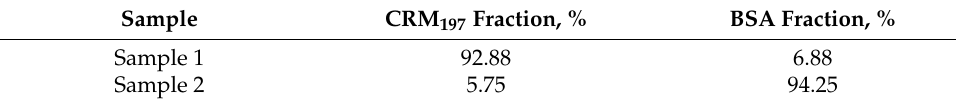
Figure 2. Electropherograms of binary mixtures of 90%CRM 197 -10%BSA ( Sample 1 ), on the left, and 10%CRM 197– 90%BSA ( Sample 2 ), on the right. Table 6. Protein fraction obtained with LabChip analysis on the BSA–CRM 197 mixture.